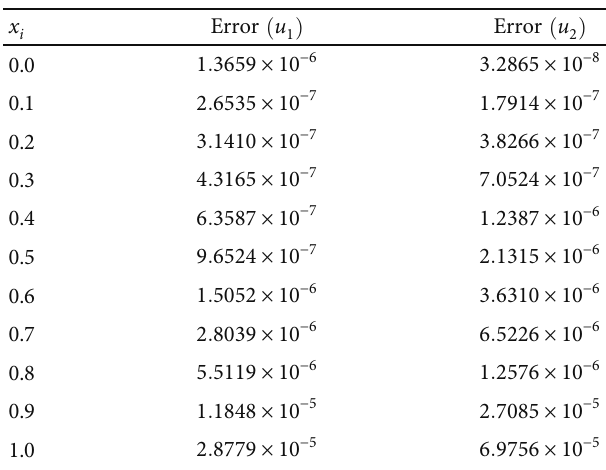
Table 6: Values of absolute errors at equally spaced points for N = 25 in Example